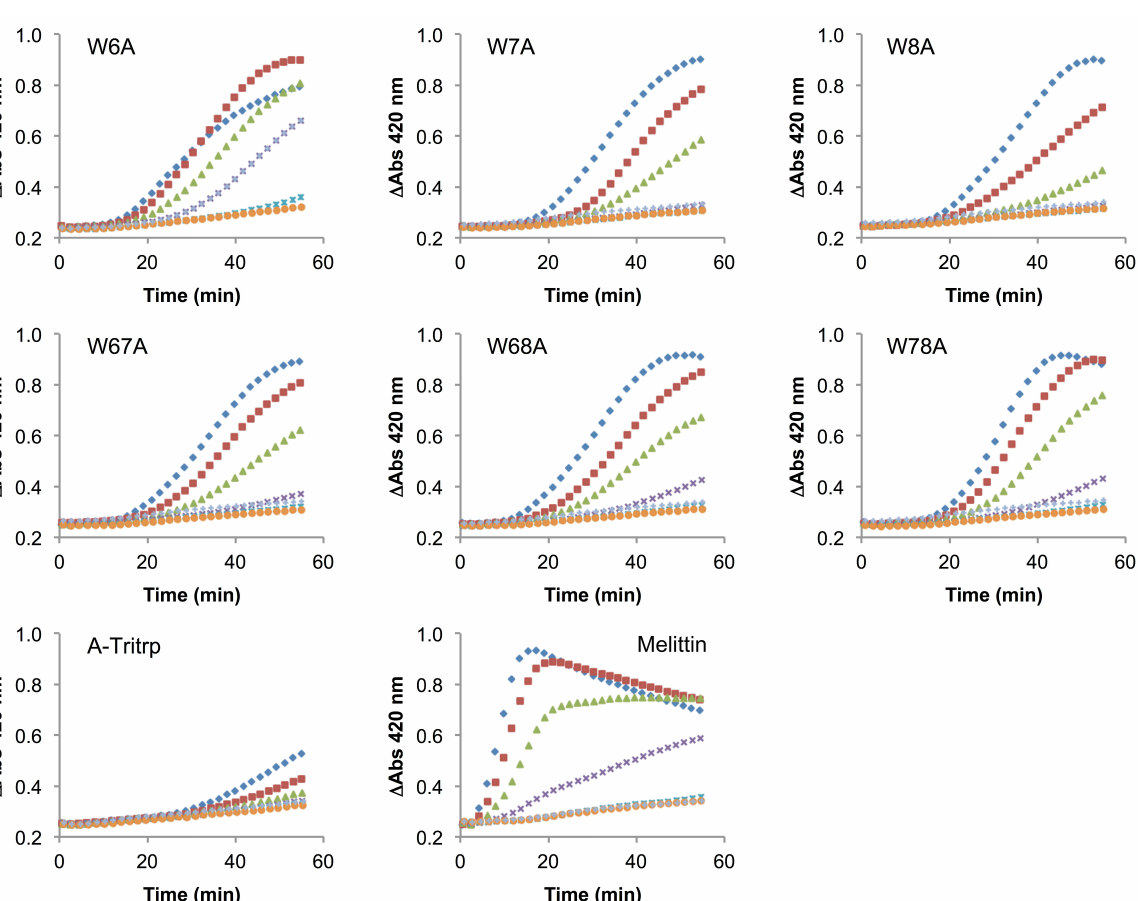
Figure 9. Inner membrane permeabilization induced by melittin and Trp-to-Ala-substituted Tritrp1 analogs. Peptide concentrations were MIC ( ♦ ), 1 / 2 MIC ( (cid:132) ), 1 / 4 MIC ( ▲ ), 1 / 8 MIC ( × ), 1 / 1 / 16 MIC (*), 32 MIC ( ● ) and 0 µM ( + ). The MIC values for each peptide are derived from Table 1. For peptides with a range of MICs, the higher concentration was used. For A- Tritrp, the highest peptide concentration selected was 128 µM. The results are the average of three independent experiments, and the standard deviation (SD) for two selected peptide concentrations are depicted in Figure